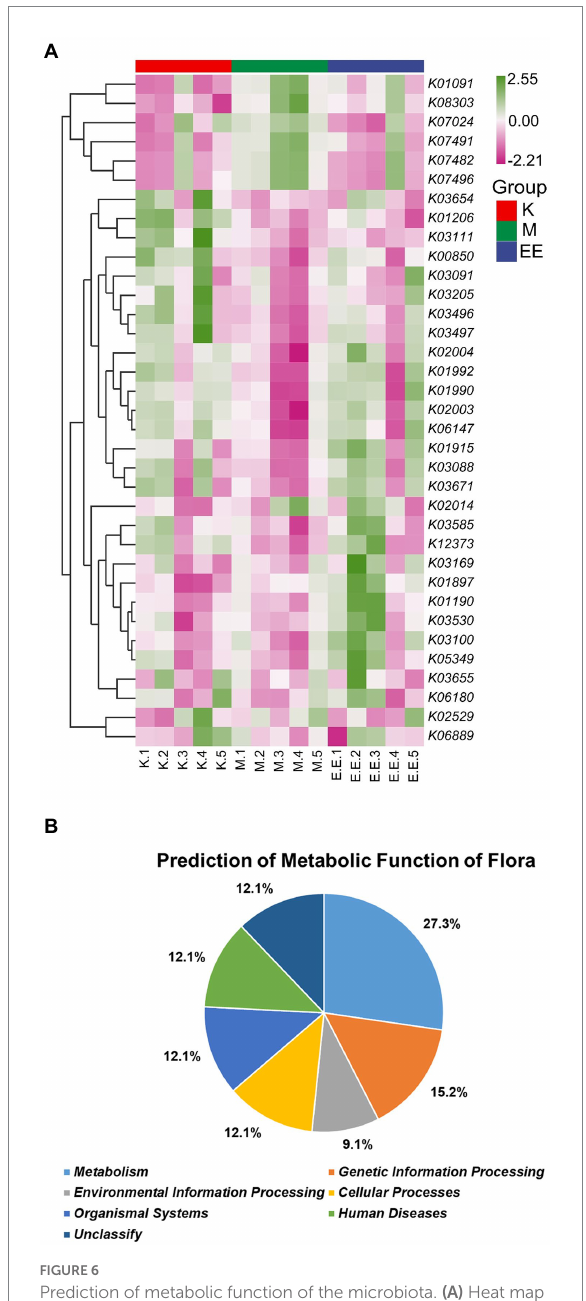
FIGURE 6 Prediction of metabolic function of the microbiota. (A) Heat map of the predicted metabolic functions of the flora based on the KO database (top 35). The horizontal coordinate is the sample name and the vertical coordinate is the associated metabolic pathway number, N = 5; (B) Plot of the predicted metabolic functions of the flora as a